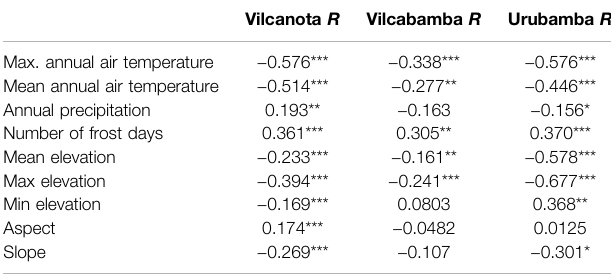
TABLE 1 | Correlation coef fi cients for drivers of ice area change. Full table and graphs are given in the Supplementary Table S7 and Supplementary Figure S8 . Signi fi cance ( p ) denoted as * = p < 0.1, ** = p < 0.05, *** = p < 0.01. Vilcanota R Vilcabamba R Urubamba